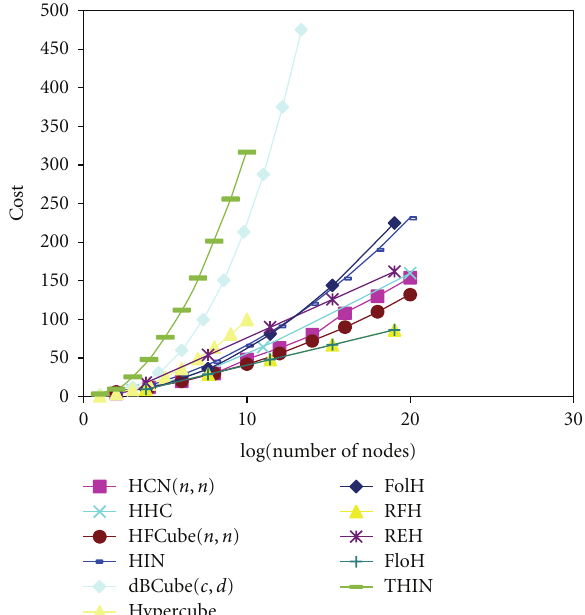
Figure 22: Comparison in terms of the cost ( = degree × diameter).